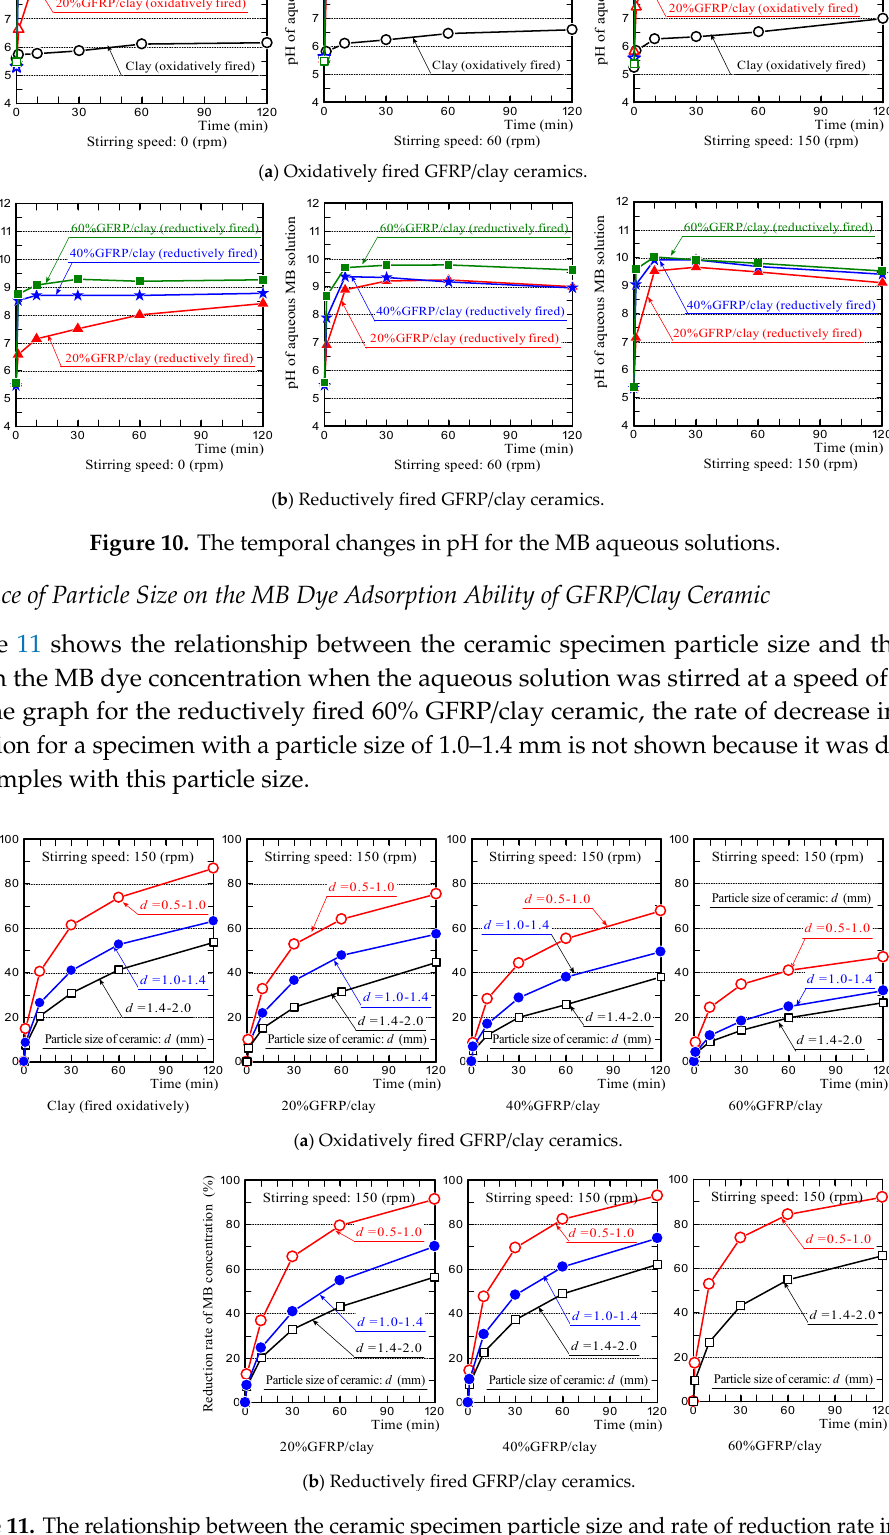
Figure 11. The relationship between the ceramic specimen particle size and rate of reduction rate in the MB dye